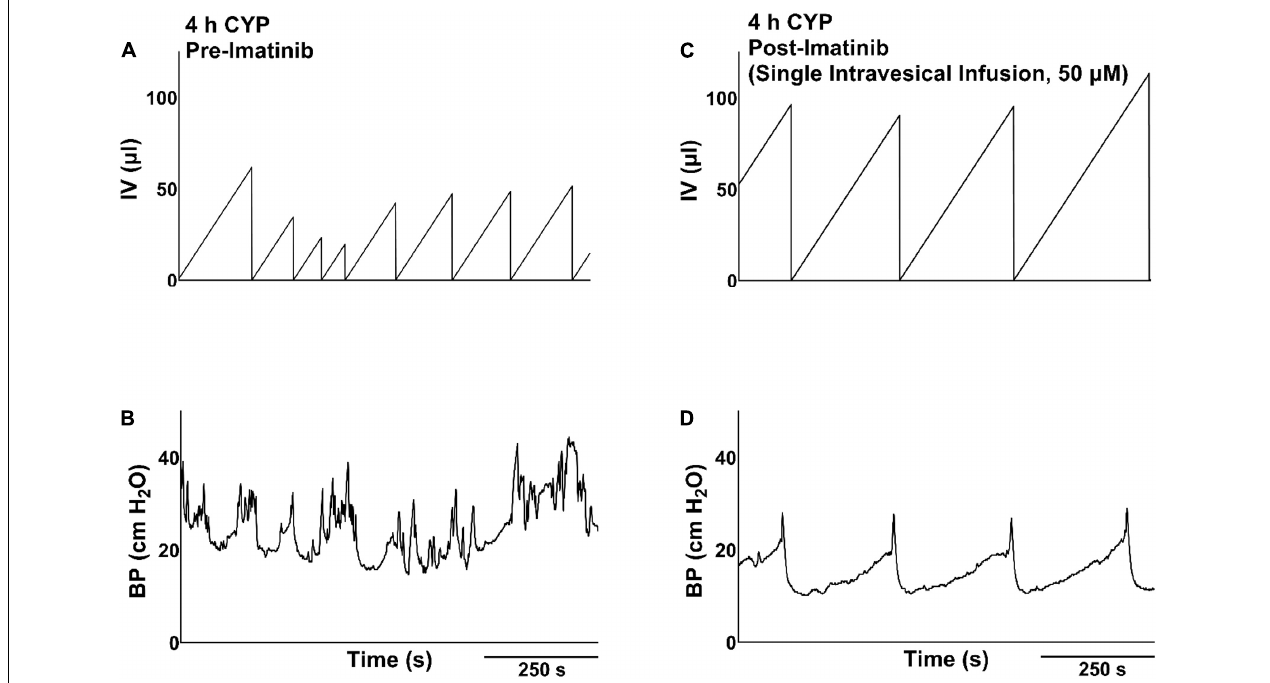
FIGURE 4 | Representative bladder function cystometry recordings from a female mouse with acute CYP-induced cystitis, before and after imatinib mesylate treatment via intravesical infusion. (A,B) Before imatinib treatment via intravesical infusion, mice with acute CYP-induced cystitis (200 mg/kg, 4 h, i.p.) exhibited decreased IMI and IV. (C,D) After imatinib treatment via intravesical infusion (50 µ M, 30 min, 0.5 ml), mice with 4 h CYP-induced cystitis exhibited significantly ( p ≤ 0.0001) increased IMI and IV. Recordings displayed are from the same mouse, before and after imatinib treatment. Mice with 4 h CYP-induced cystitis in these experiments acted as their own controls. n = 6–10. By two-way repeated measures ANOVA with Šídák’s multiple comparisons test. CMG, cystometrogram; BP, bladder